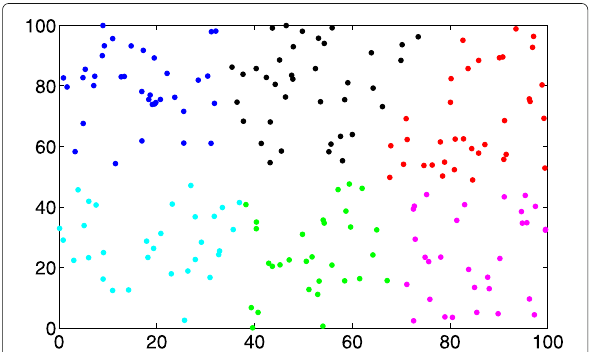
Fig. 3 The six clusters for 200 nodes by spectral partitioning method. Two hundred sensor nodes are partitioned into six clusters using our proposed spectral partitioning